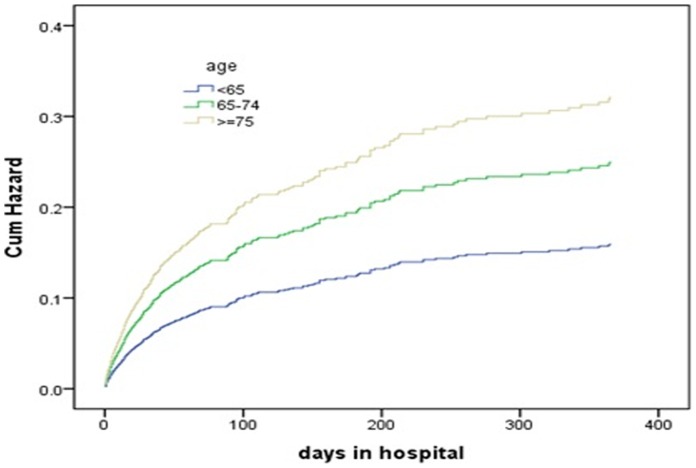
Predicted cumulative hazard function of 1 year mortality for different age groups of patients.The curves were constructed according to the age groups with the use of Cox regression analysis.